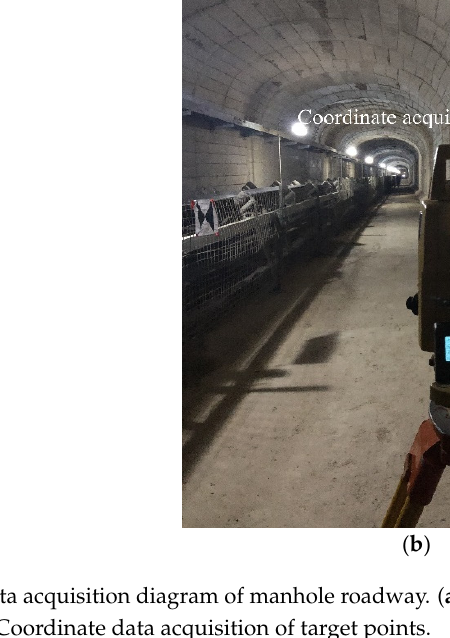
Figure 5. Point cloud data acquisition diagram of manhole roadway. ( a ) Point cloud data acquisition of 3D laser scanner; ( b ) Coordinate data acquisition of target points.